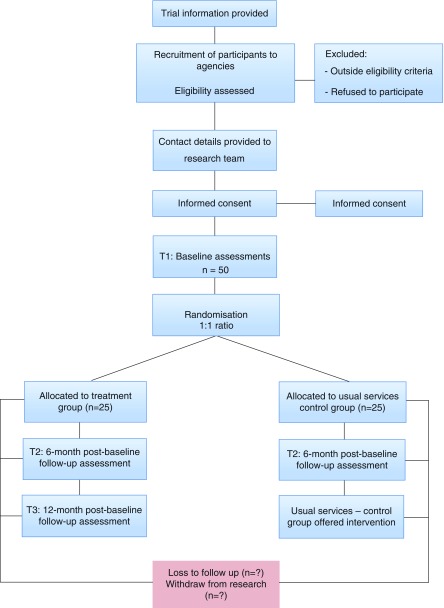
Study Flow Diagram.